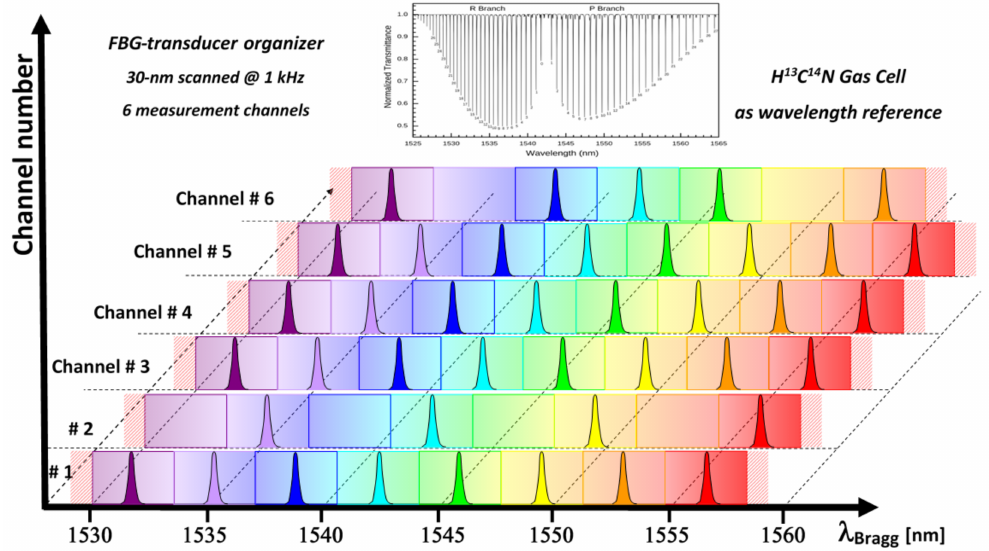
Figure 2. FBG transducers typical spectral allocation table to prevent spectral crossing. The sensor number is indicative: several tens of sensors may be easily interrogated depending on the measurand dynamic. Also shown at the top: a wavelength reference channel based on a gas cell providing absolute spectral calibration in real time of the monitoring system.